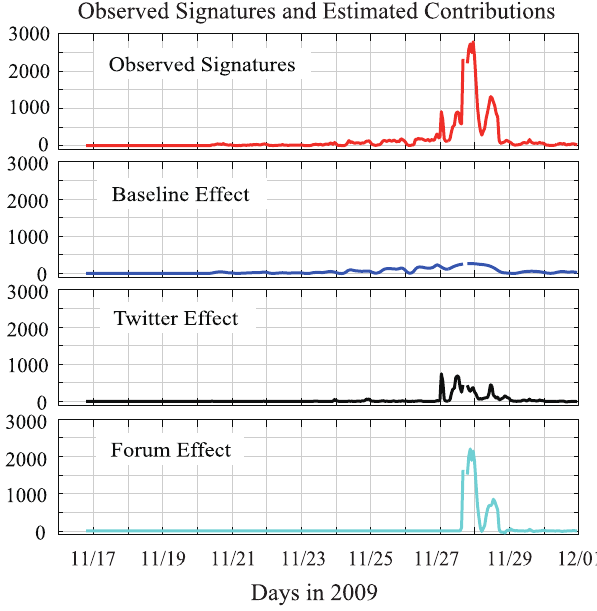
Figure 2. The observed signatures and decomposed profiles of each effect. The observed hourly-counted numbers of signatures ( y n ) and the estimated hourly-counted Baseline effect ( b n ), Twitter effect ( t n ), and Forum effect ( u n ) by the decomposition model are shown. The estimated profiles are based on the smoothing estimates from Kalman